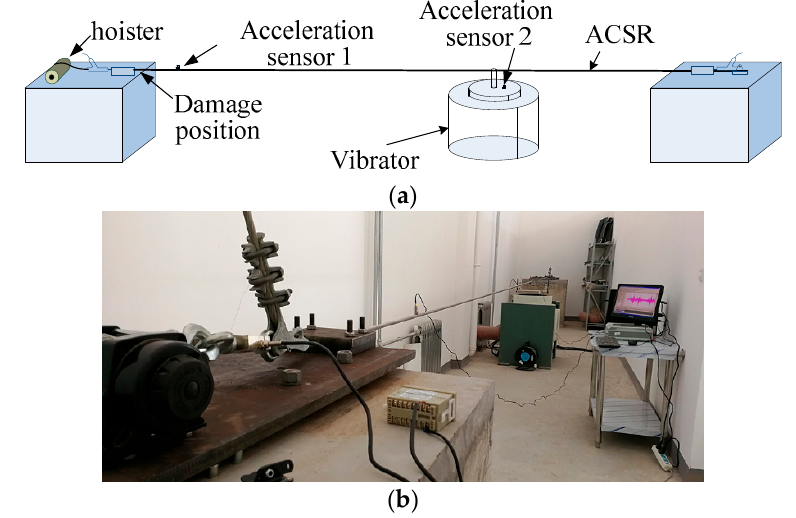
Figure 3. Experiment platform: ( a ) Schematic of the experimental platform; ( b ) Photograph of the experimental platform. ACSR = aluminum conductor steel reinforced.